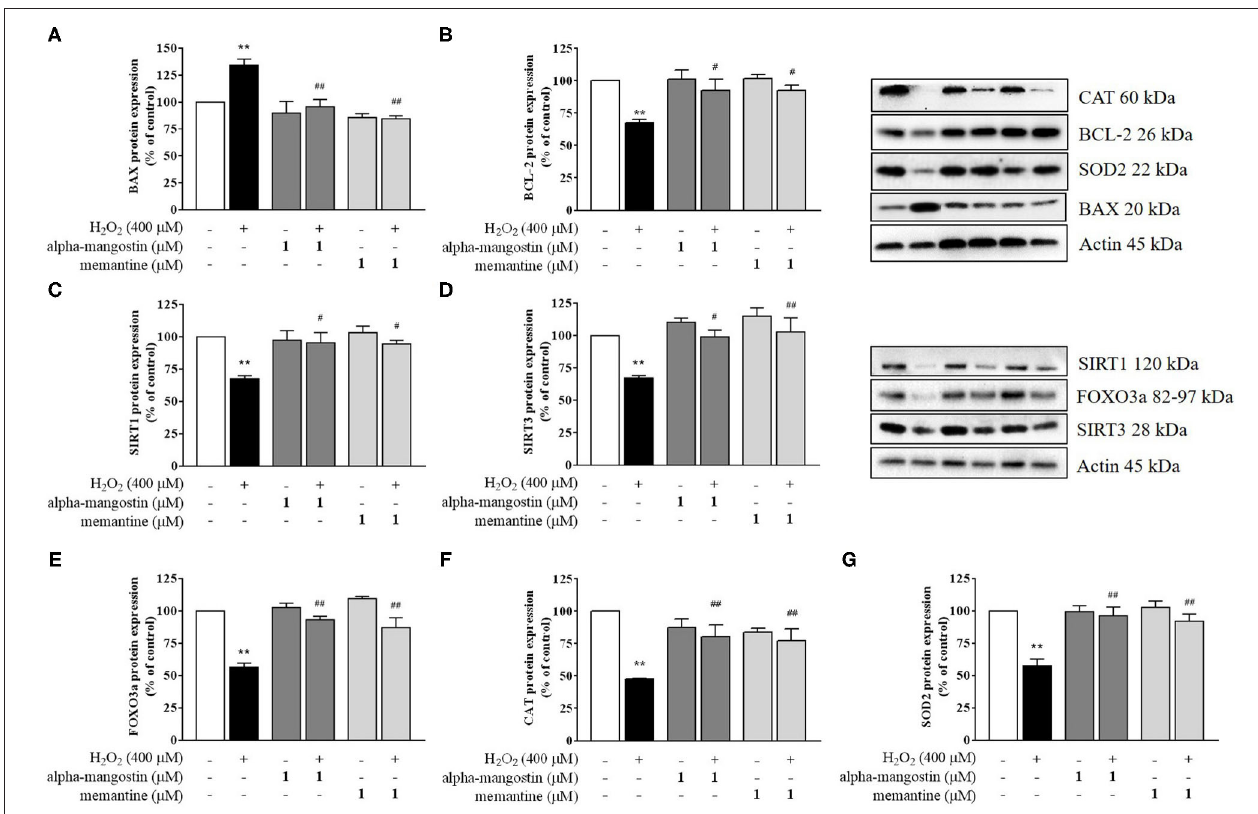
FIGURE 3 | Regulation of sirtuin by alpha-mangostin attenuated H 2 O 2 -induced neurotoxicity in SH-SY5Y cells. The cells were pretreated with/without 1 µ M alpha-mangostin and memantine for 3h prior to H 2 O 2 exposure. The protein expressions of (A) BAX, (B) BCL-2, (C) SIRT1, (D) SIRT3, (E) FOXO3a, (F) CAT, and (G) SOD2 were determined by Western blot. Data are presented as mean ± SEM of three independent experiments. ** P < 0.01 vs. control and # P < 0.05, ## P < 0.01 vs. H 2 O 2